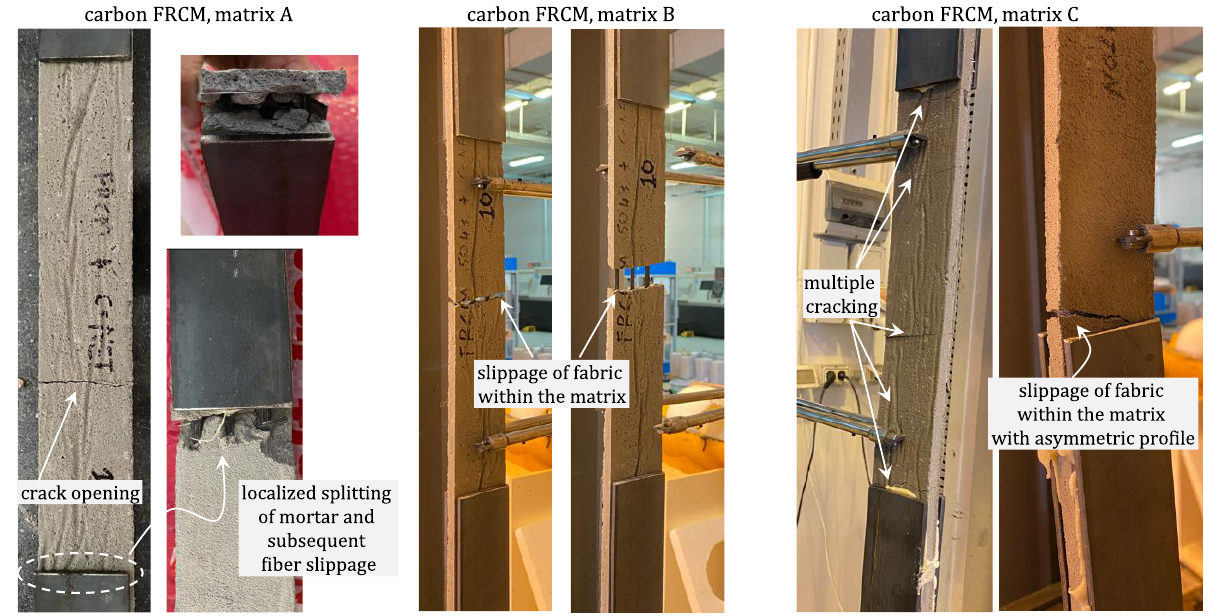
Figure 11. Failure mechanisms of carbon FRCM coupons realized with different cement-based matrices.